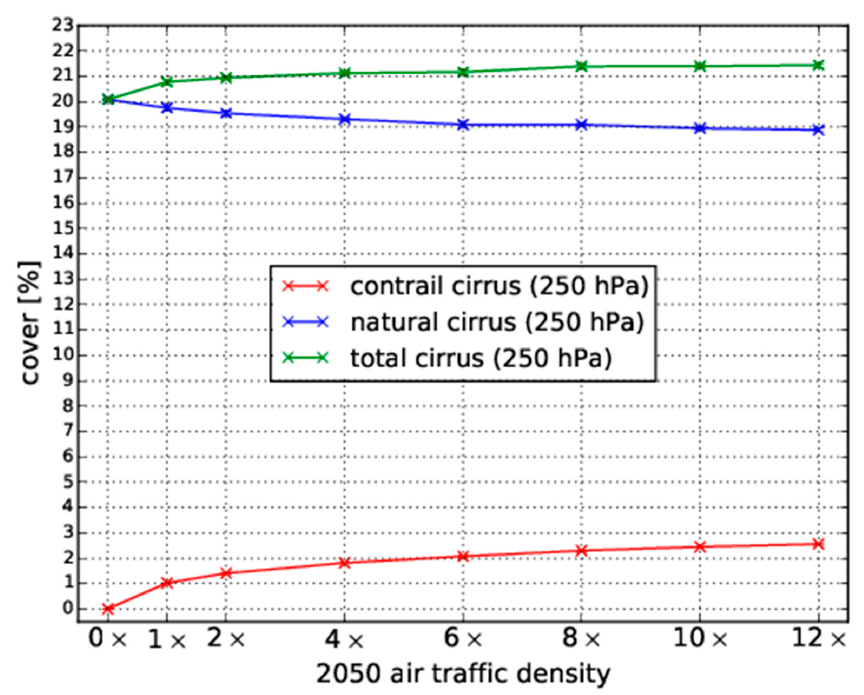
Figure 2. Global mean coverage (in %) at 250 hPa for all (green), natural (blue), and aircraft-induced (red) cirrus clouds, derived from the contrail cirrus simulations using the 2050 aviation inventory of [27] with different scaling factors as indicated on the abscissa (same simulations as reported by [16]). Statistical uncertainties are so small that they cannot be deciphered from the